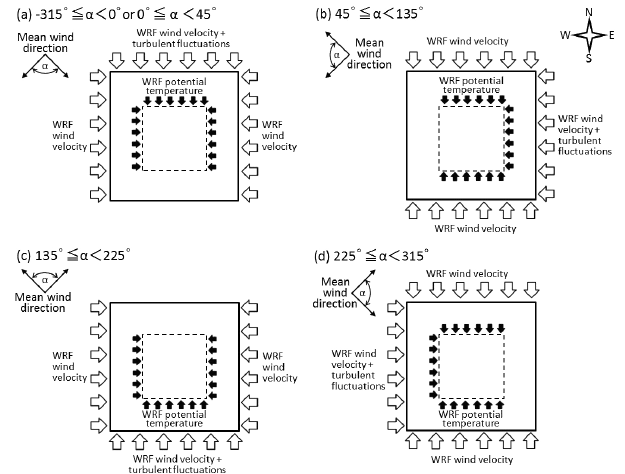
Figure 1. Schematic diagram of the treatment of inflow boundary conditions in the CFD model depending on mean wind directions in the meteorological field. The solid and dotted lines are compu- tational regions to drive turbulent winds and simulate thermally- stratified boundary layers, respectively. The open and filled arrows indicate input of wind velocities and potential temperature obtained by a MM model, respectively.